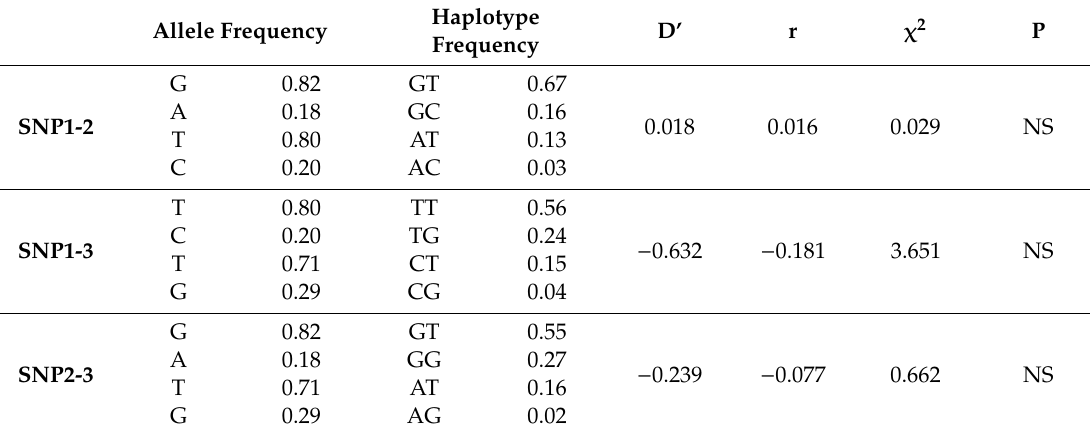
Table 2. Allele and haplotype frequency distribution and linkage disequilibrium in the case of tested SNPs.